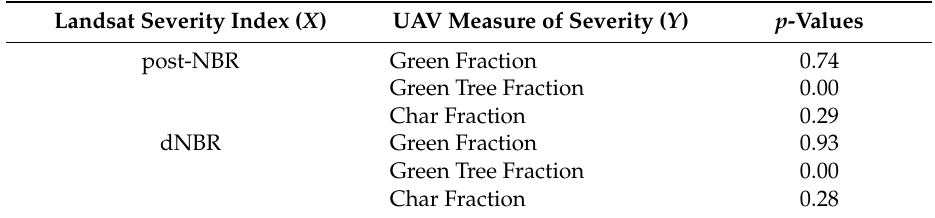
Table 3. Test predictions for statistical differences ( p = 0.05) from non-linear models employing independent validation samples using a Wilcoxin signed-rank test.